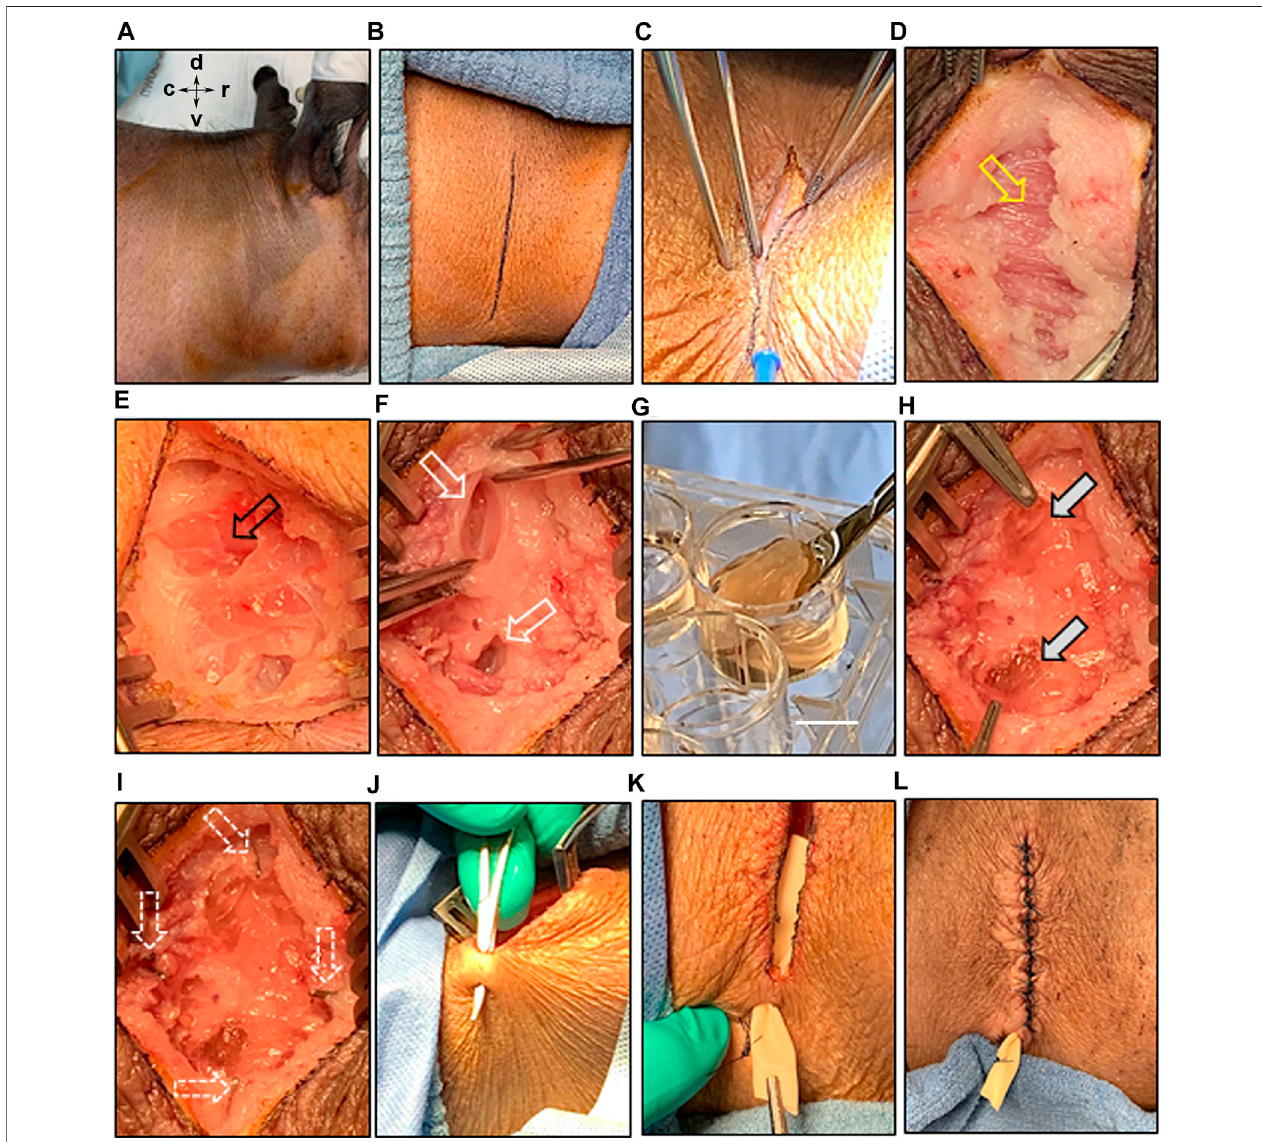
FIGURE5| Implantationof3D-STintotheirradiatedparotidbed. (A) Preppingoftheirradiatedsurgicalsitewithantisepticagents;fororientation:dorsal(d),ventral (v), caudal (c), and rostral (r); (B) an incision mark was placed on the skin, overlaying the position of the parotid gland; (B – D) surgical separation of the various skin layers andtheconnectivelayerwithplatysma fi bers(yellowarrow)underneath; (E) exposureoftheparotidgland(blackarrow); (F) creationoftwopocketsintotheparotidgland bed; (G – H) delivery of the 3D-ST implant under sterile conditions; scale bar (cid:1) 1 cm, allowing implantation into the glandular pockets (grey arrows); (I) multiple ligationsurgicalclipswere placed toorient thelocation ofthetwo pockets inthe gland (white arrows); (J – K) ventral tothe surgicalincision site, aholewasmade through the skin to place a Penrose drain, which was sutured to the outside of the skin; (L) careful closing of the surgical site by suturing the connective tissue and various skin